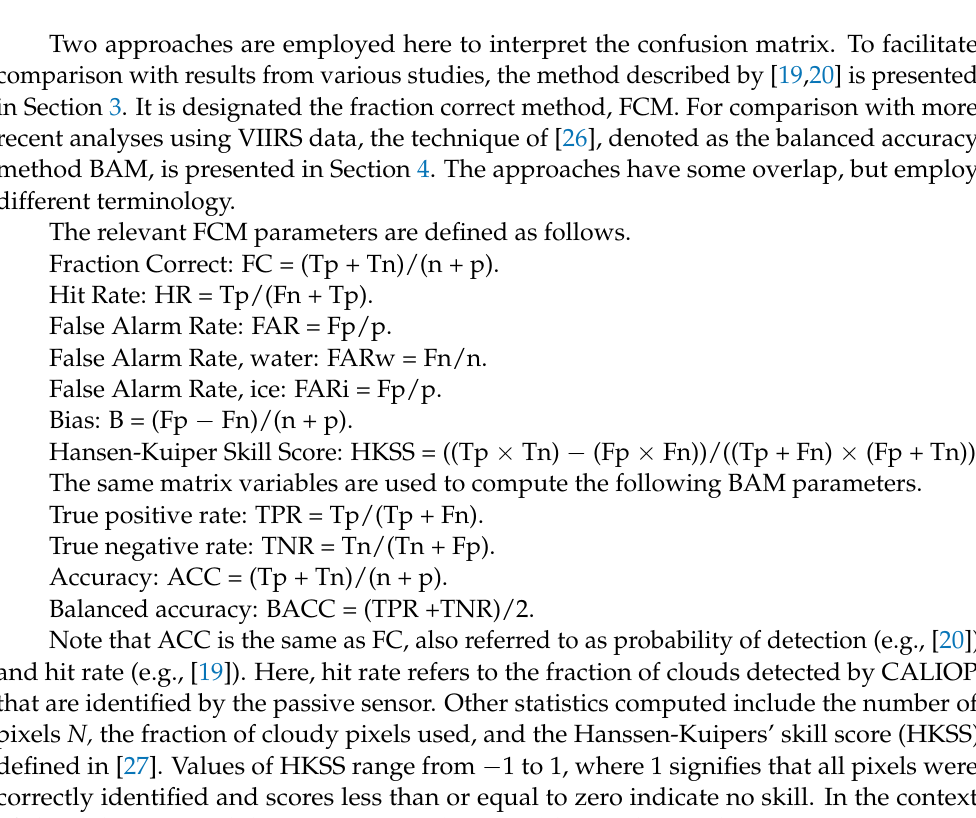
Table 1. Confusion matrix for evaluating cloud fraction (phase). VIIRS CALIPSO Clear (Liquid) Cloudy (Ice) Sum Clear (liquid)